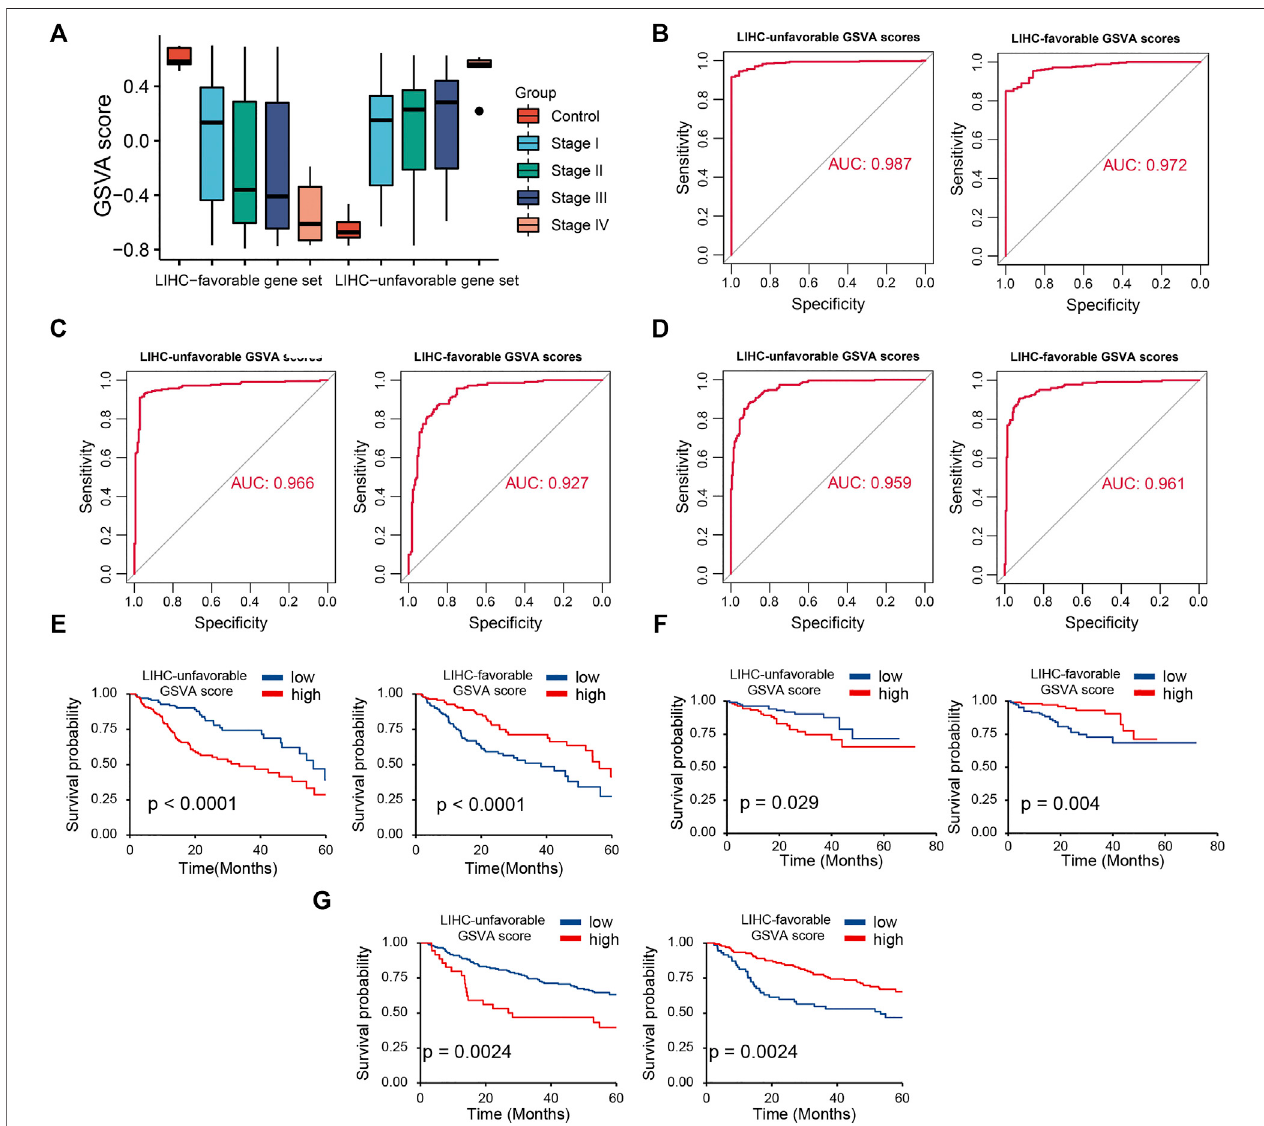
FIGURE 4 | Diagnostic and prognostic abilities of LIHC-unfavorable GSVA score (LUG score) and LIHC-favorable GSVA score (LFG score). (A) Box plot of LUG score and LFG score in different LIHC stages. (B – D) ROC curves analysis of LUG score and LFG score in TCGA, ICGC and GSE14520. (E – G) Survival analysis of LUG score and LFG score in TCGA, ICGC and